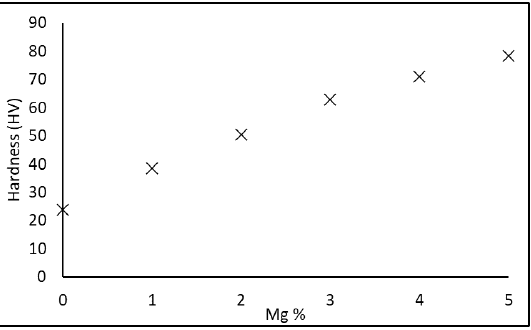
Figure 3. The hardness behavior vs. Mg content percentiles based on the averages at each condition. Table 5. The results of two-sample t -test for the hardness data.